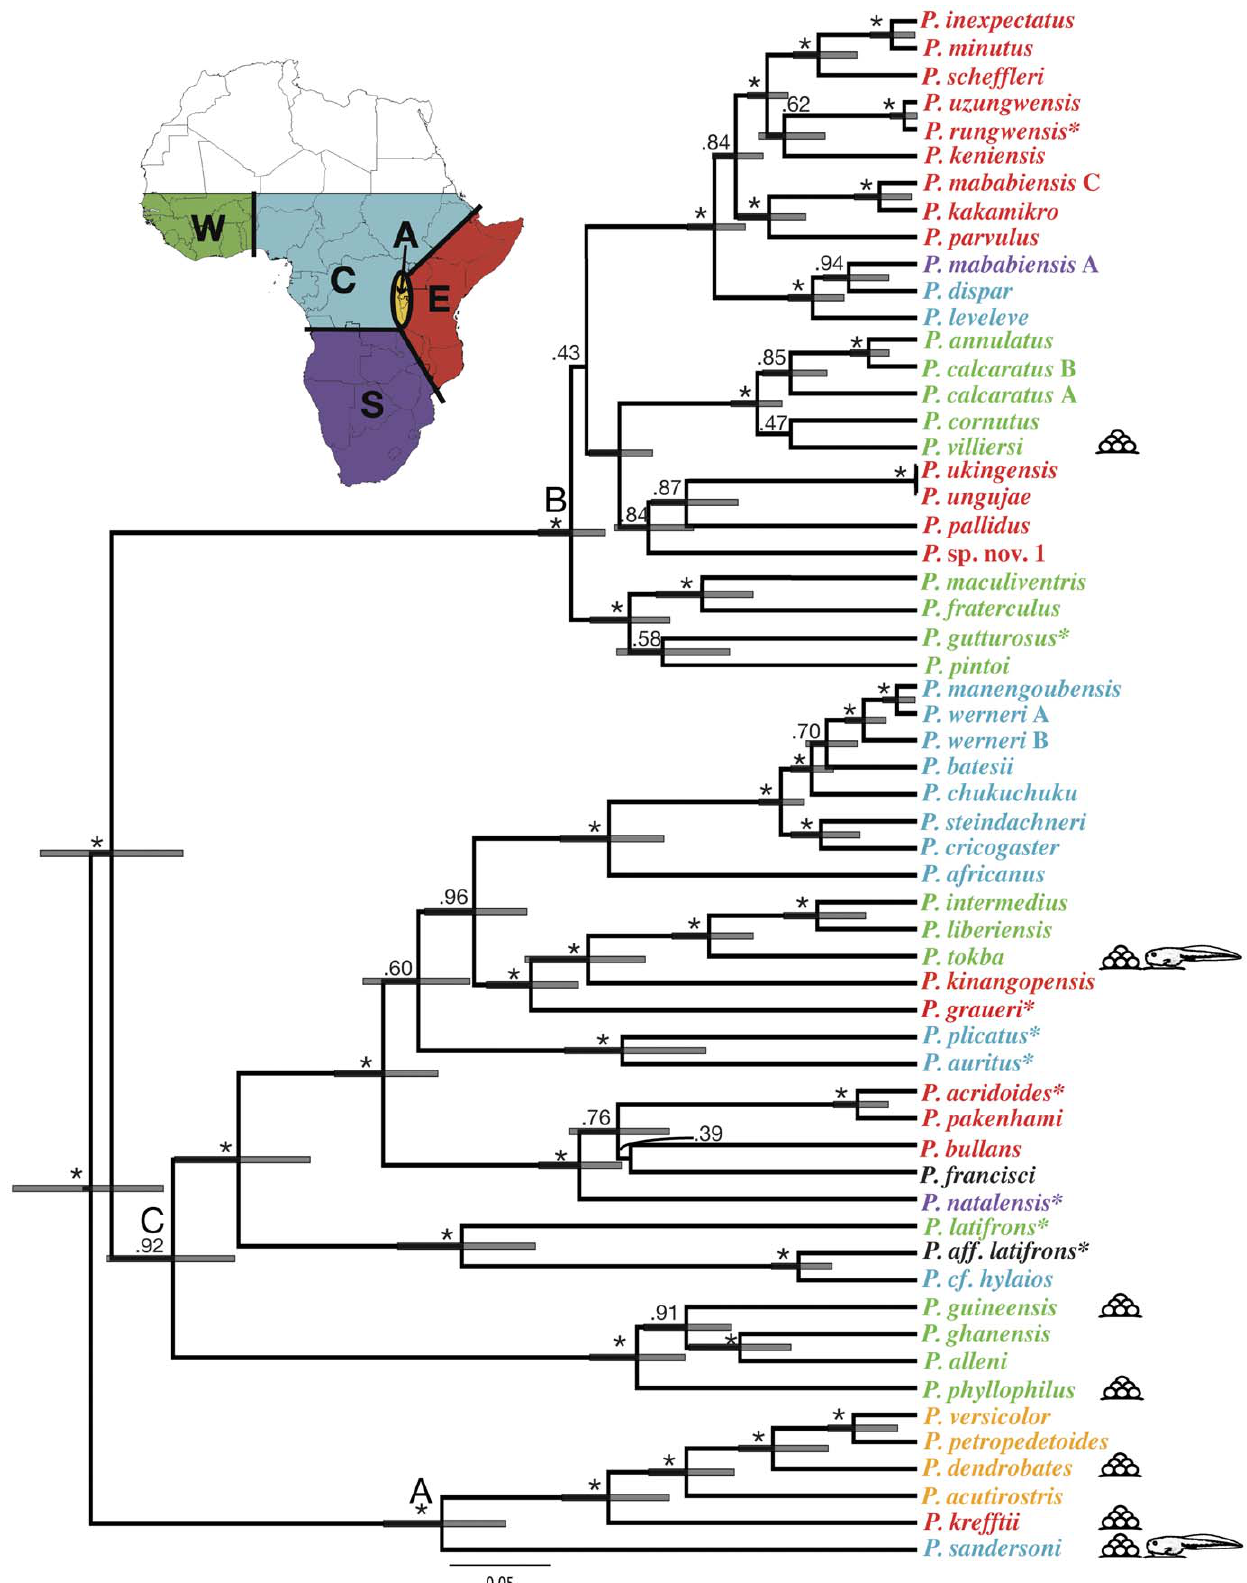
Figure 1. Chronogram of puddle frogs diversification and origins of terrestrialization showing relative time reconstructed using *BEAST. Species are color-coded according to their distribution within five geographic zones (see map inset): (1) western Africa, green; (2) central